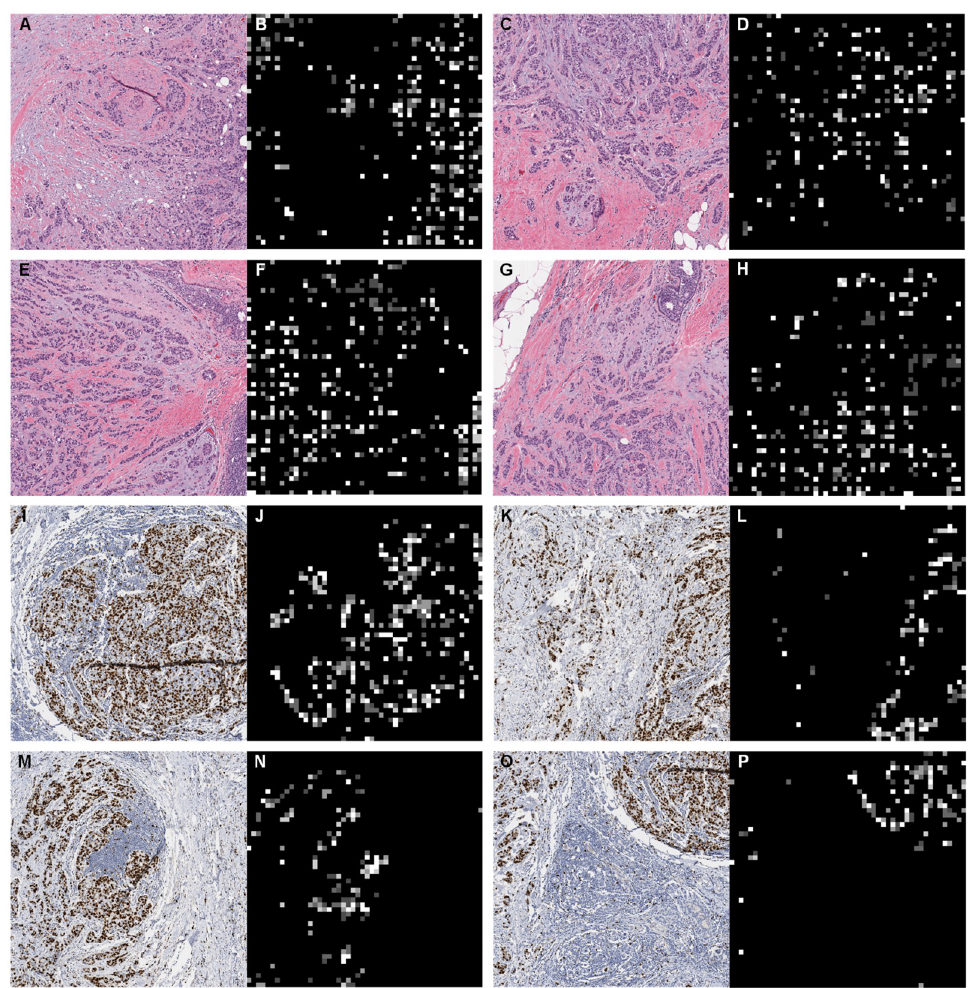
color regions on WSI images) are assigned with high attention weights (i.e. bright regions on